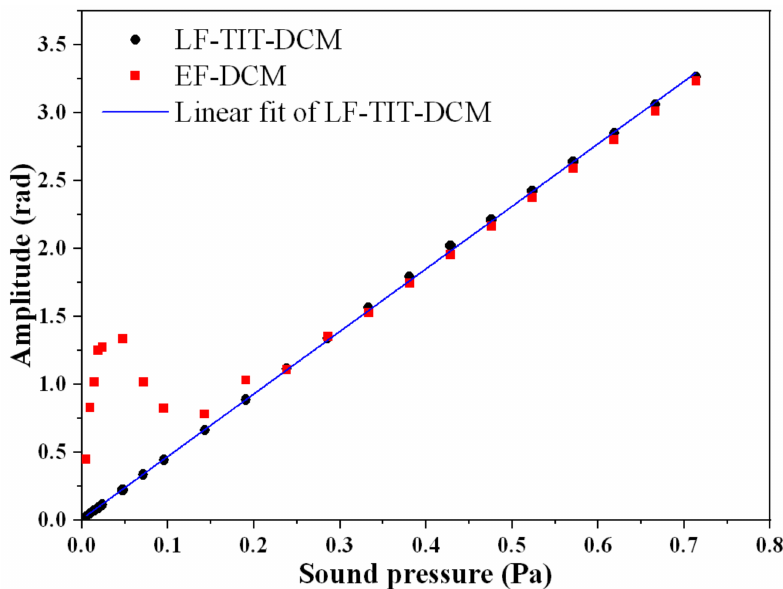
Figure 5. Comparison of linear response between LF-TIT-DCM-based passive homodyne phase demodulation and EF-DCM-based passive homodyne phase